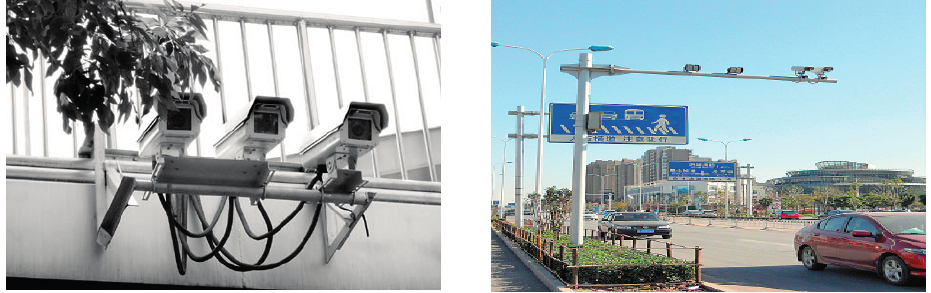
Figure 2. Multi-cameras road monitoring systems.